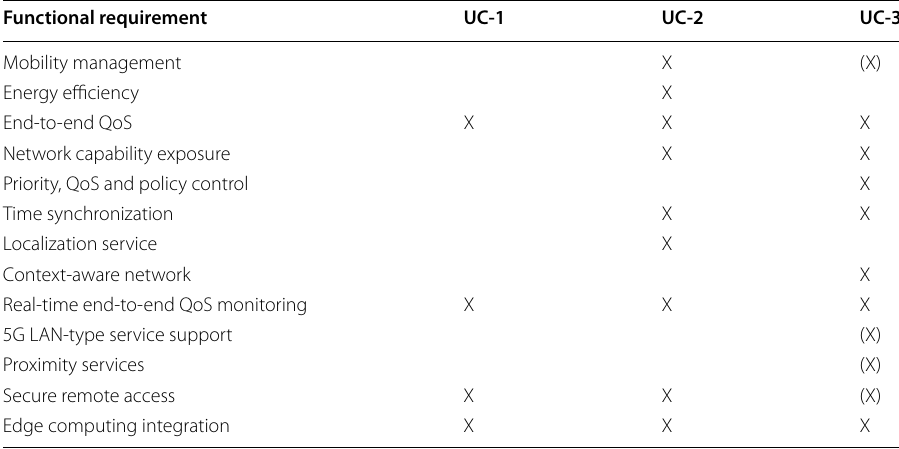
Table 2 Functional requirements